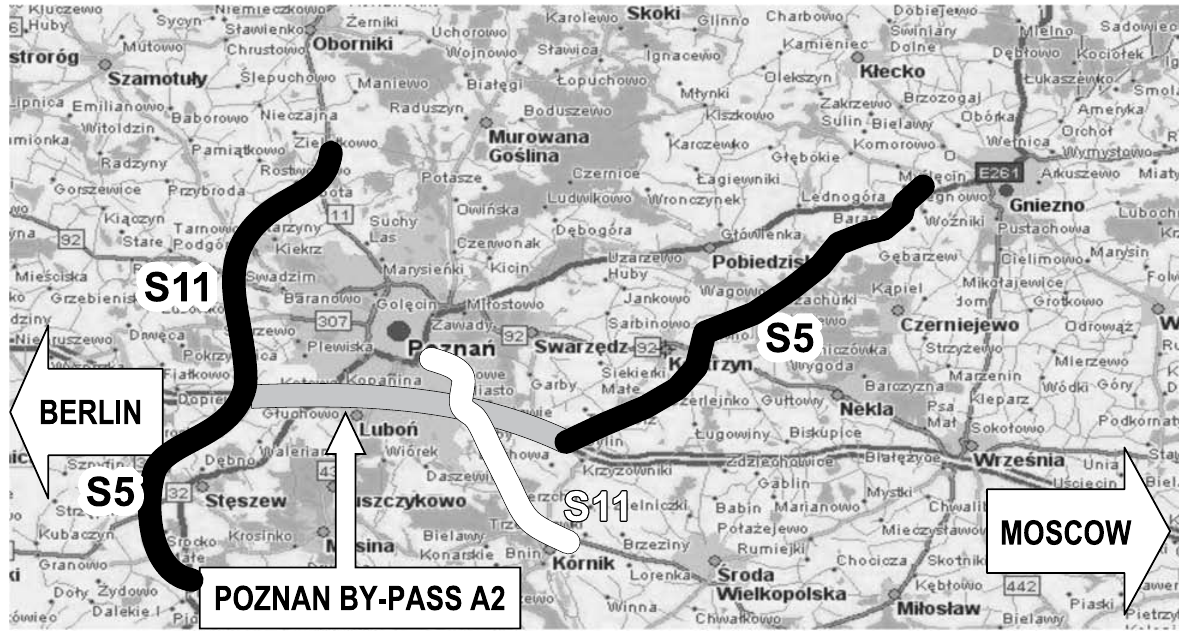
Fig. 3. The general idea of transportation system near Poznan (black colour – planned expressways S5 and S11, gray colour – POZNAN BY-PASS A2 in operation, white colour – expressway S11 in